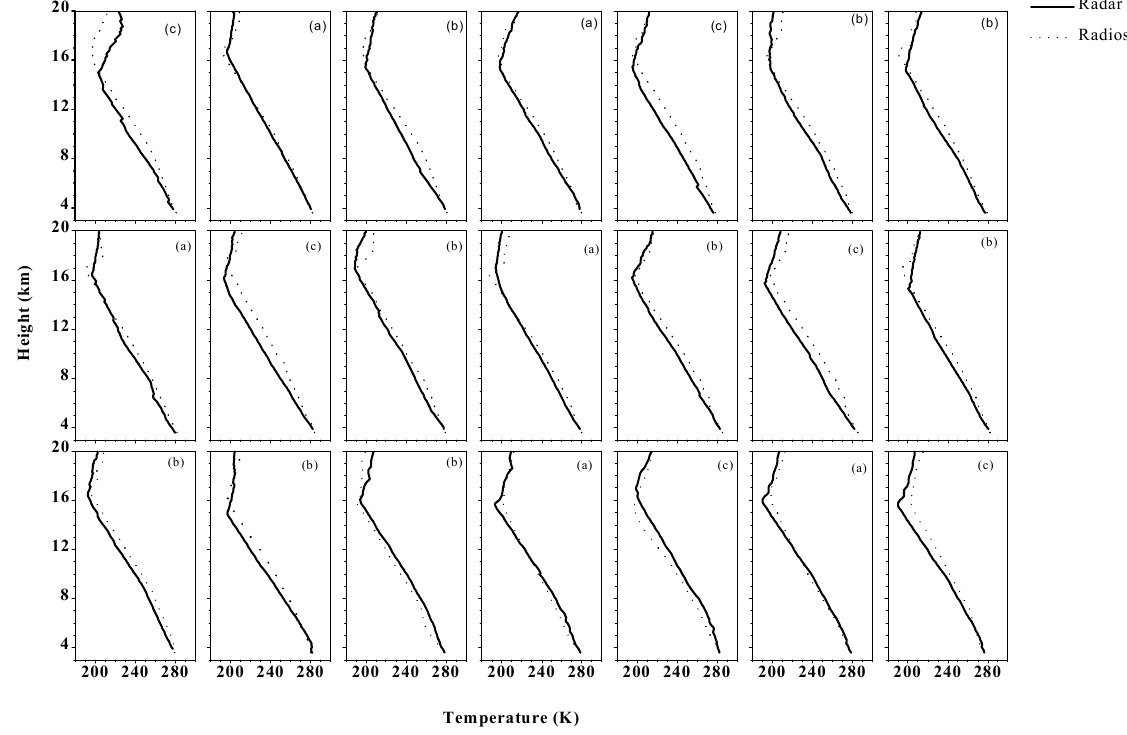
Fig. 4. Comparison of radar derived temperature profiles with radiosonde measured temperature profiles during the radar-radiosonde cam- paign period during July–August 1999. The solid lines correspond to radar derived temperature profiles and dashed lines correspond to radiosonde measured temperature profiles. The labels indicate (a) clear (b) partly cloudy and (c) cloudy.